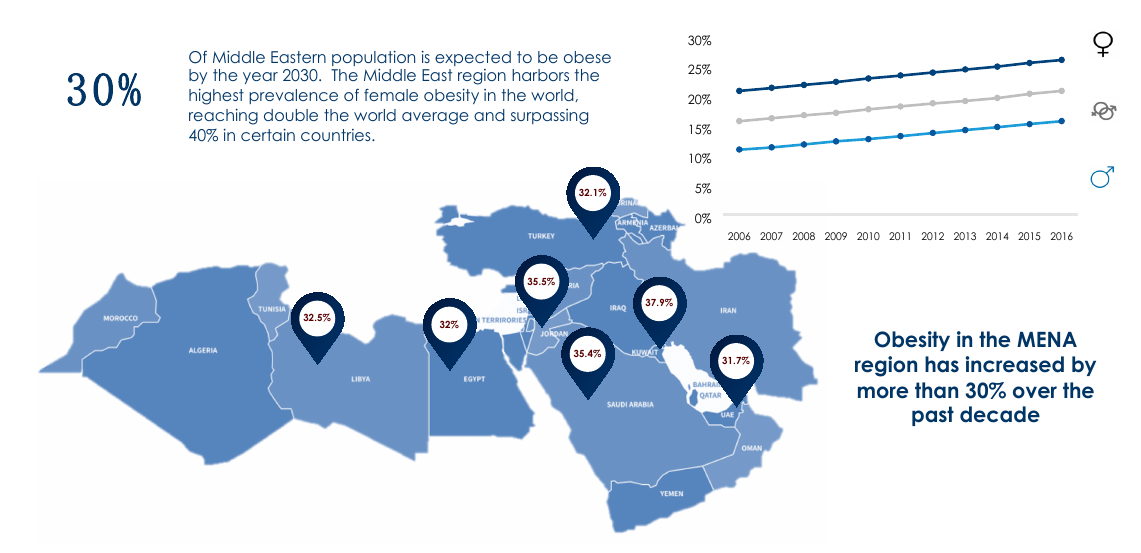
Figure 1. Prevalence of obesity in the MENA region based on WHO (2016) records [2].